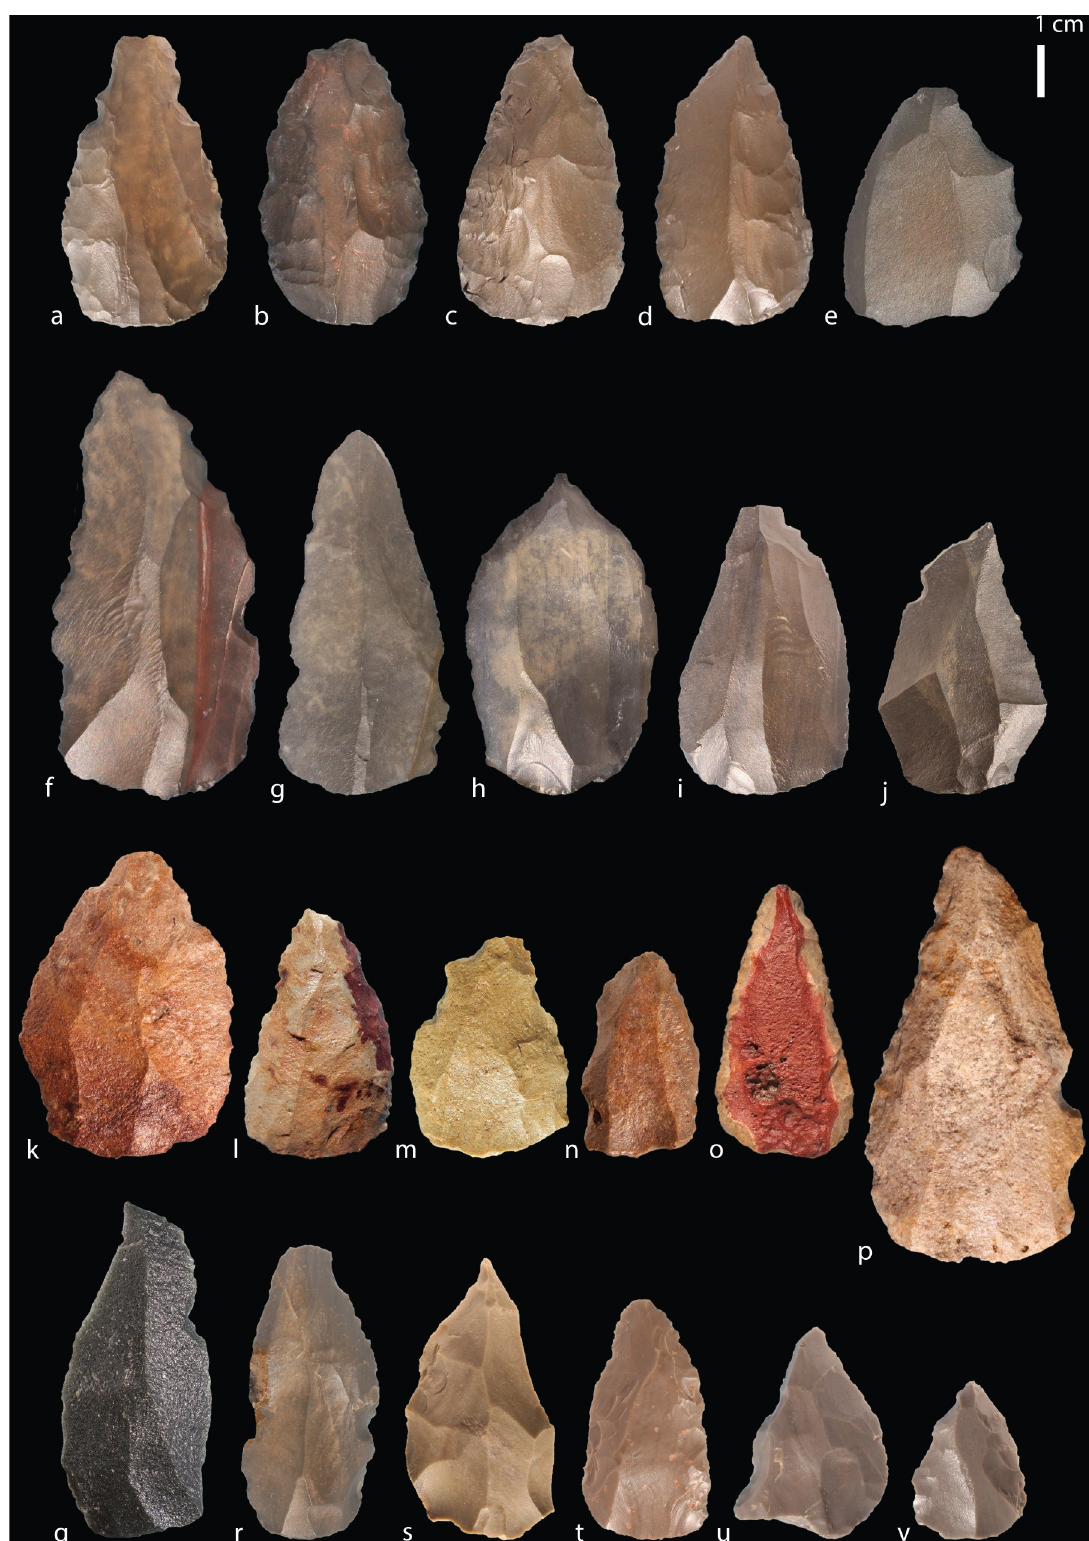
Fig 7. Tweefontein points. Raw material: (a-j) hornfels, (k-p) silcrete, (q) Dwyka quartzite, (r-v) CCS.